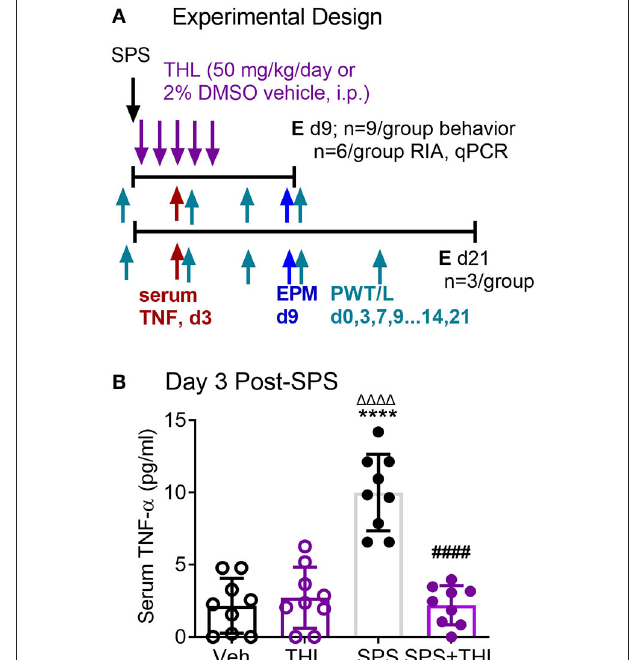
FIGURE 1 | Thalidomide (THL) prevents TNF- α increase in serum of SPS rats. (A) Experimental design includes four groups [Vehicle control (Veh), thalidomide (THL), SPS + Veh (SPS) or SPS + THL], with 9 rats/group, 6 rats/group were euthanized (E) at day 9 and 3 in each group were euthanized at day 21. Nociceptive and anxiety-like behavior testing days are noted with arrows and the designations of PWT/L and EPM, respectively. (B) Blood was withdrawn from the tail vein on day 3 and serum THL levels were determined by ELISA. Data are presented as mean ± 95% confidence interval and